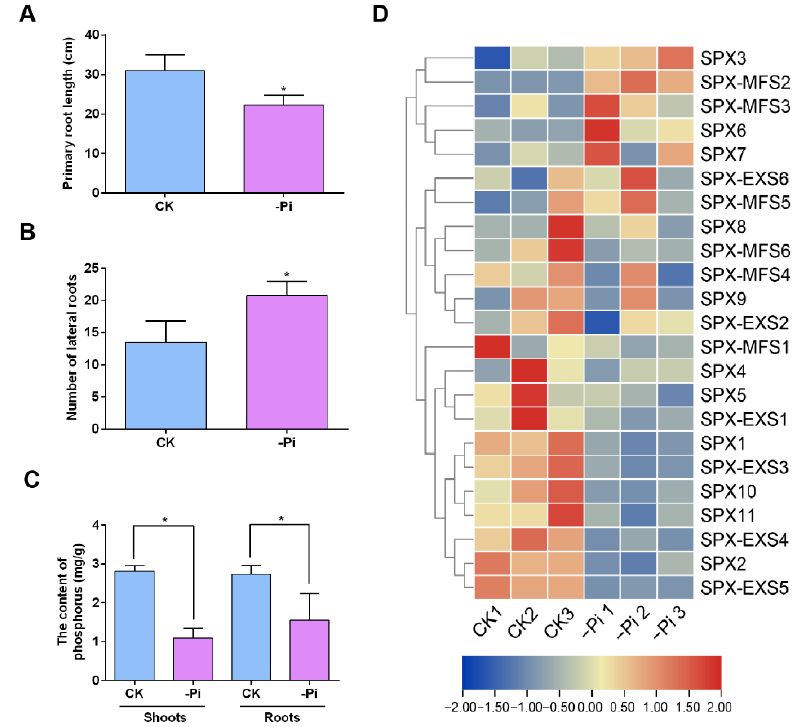
Figure 4. Expression profile of PeSPXs exposed to low phosphorus. ( A ) Primary root length of Phyllostachys edulis seedlings exposed to low phosphorus. ( B ) Number of lateral roots of P. edulis seedlings exposed to low phosphorus. ( C ) Phosphorus content in P. edulis roots and shoots exposed to low phosphorus. ( D ) Heatmap of PeSPXs exposed to low phosphorus via transcriptome analysis. Error bars in ( A – C ) indicate SD ( n = 3). The asterisk shows a significant difference compared to the control using the unpaired Student’s t test (* p < 0.05).